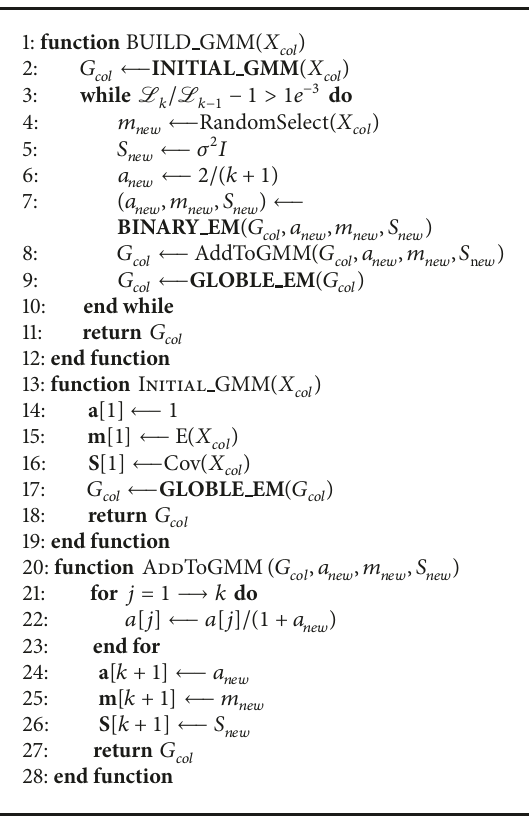
Algorithm 1: The Greedy EM